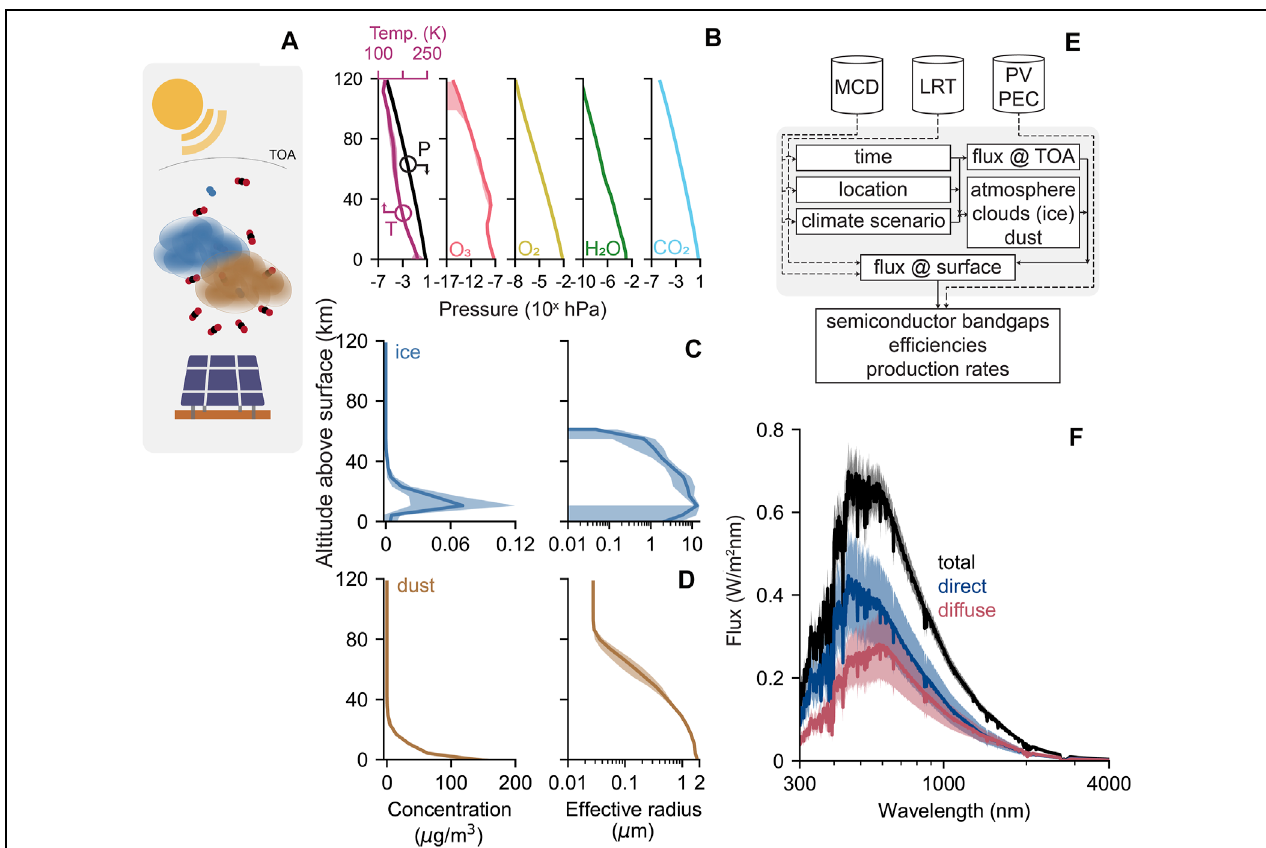
FIGURE 1 | Overview and calculation of spectral flux using atmospheric data. (A) Sunlight incident on the solar cells is mediated by orbital geometry and local atmospheric composition of gases, ice, and dust. (B,C, and D) Temperature, partial pressure of atmospheric gases and concentration and effective radii of ice and dust particles as a function of altitude above the surface. (E) Information flow in the calculation scheme. Dotted lines represent functions used for calculations; solid lines represent data used as parameters. MCD, Mars Climate Database; LRT, LibRadtran. (F) Total (black), direct (blue), and diffuse (red) solar flux at Jezero Crater at solar noon averaged over the course of a typical Martian year. In (B) , (C) , (D) , and (F) , solid lines represent yearly averages and shaded regions represent the standard deviation due to seasonal